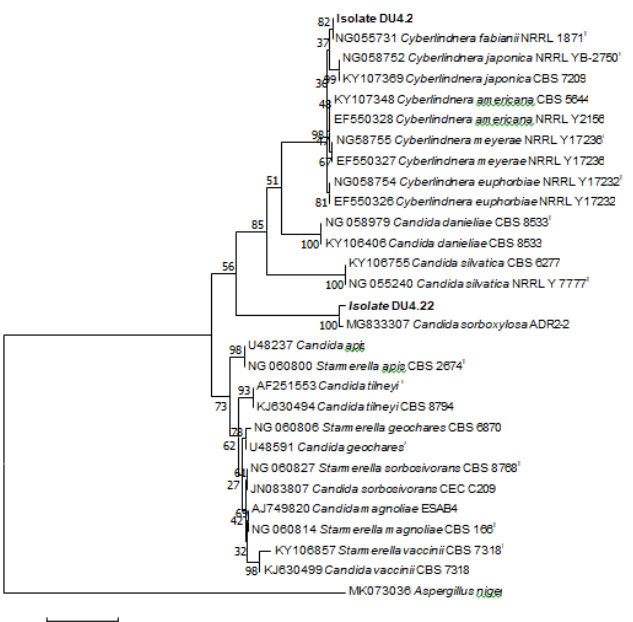
Fig. 6. Phylogenetic tree of isolate DU4.2 and isolate DU4.22, constructed using MEGA 5 software with the Joining Neighbor (NJ) method (1000x Bootstrap). Aspergillus niger was used as outgroup of the tree and the sequence collection were taken from NCBI.